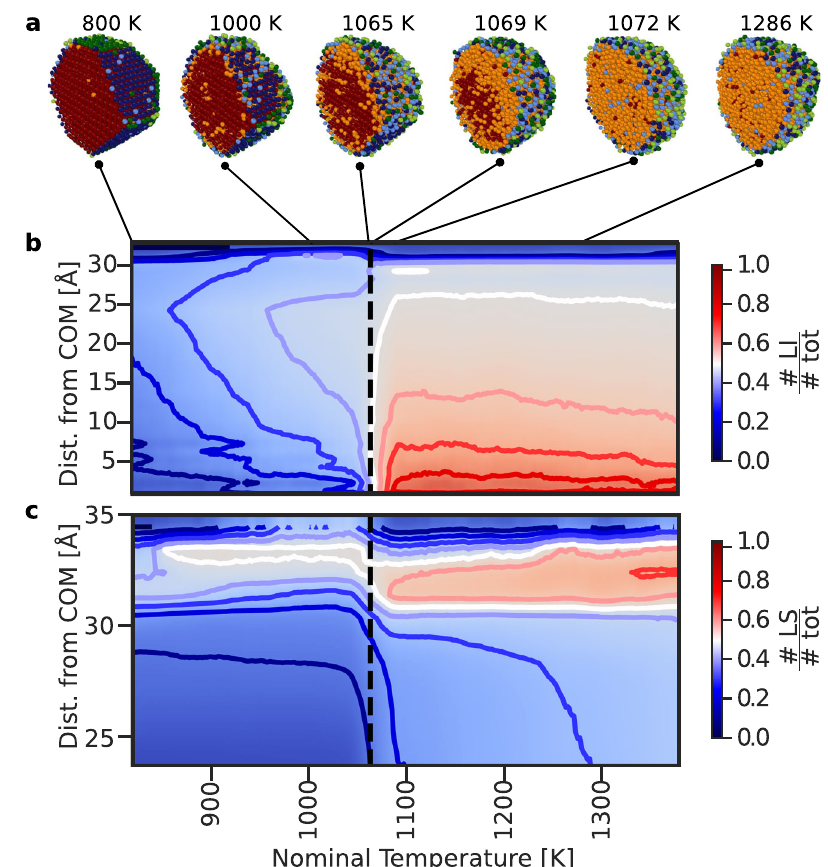
Fig. 3 Distribution of liquid environments in an Au 6266 NP. a Snapshots of Au 6266 simulated using the rPBE ML-FF at different nominal simulation temperatures, with atoms coloured according to the clustering algorithm, and using the same colour scheme as in Fig. 1. b , c Average fraction of #LI ( b ) and #LS ( c ) local atomic environments as a function of the radial distance from the COM ( y -coordinate), and of the nominal system temperature ( x -coordinate). The bold coloured lines in ( b , c ) indicate the isosurfaces in the plot, from 0 to 1 every 0.1, while the black dashed line indicates the T NP